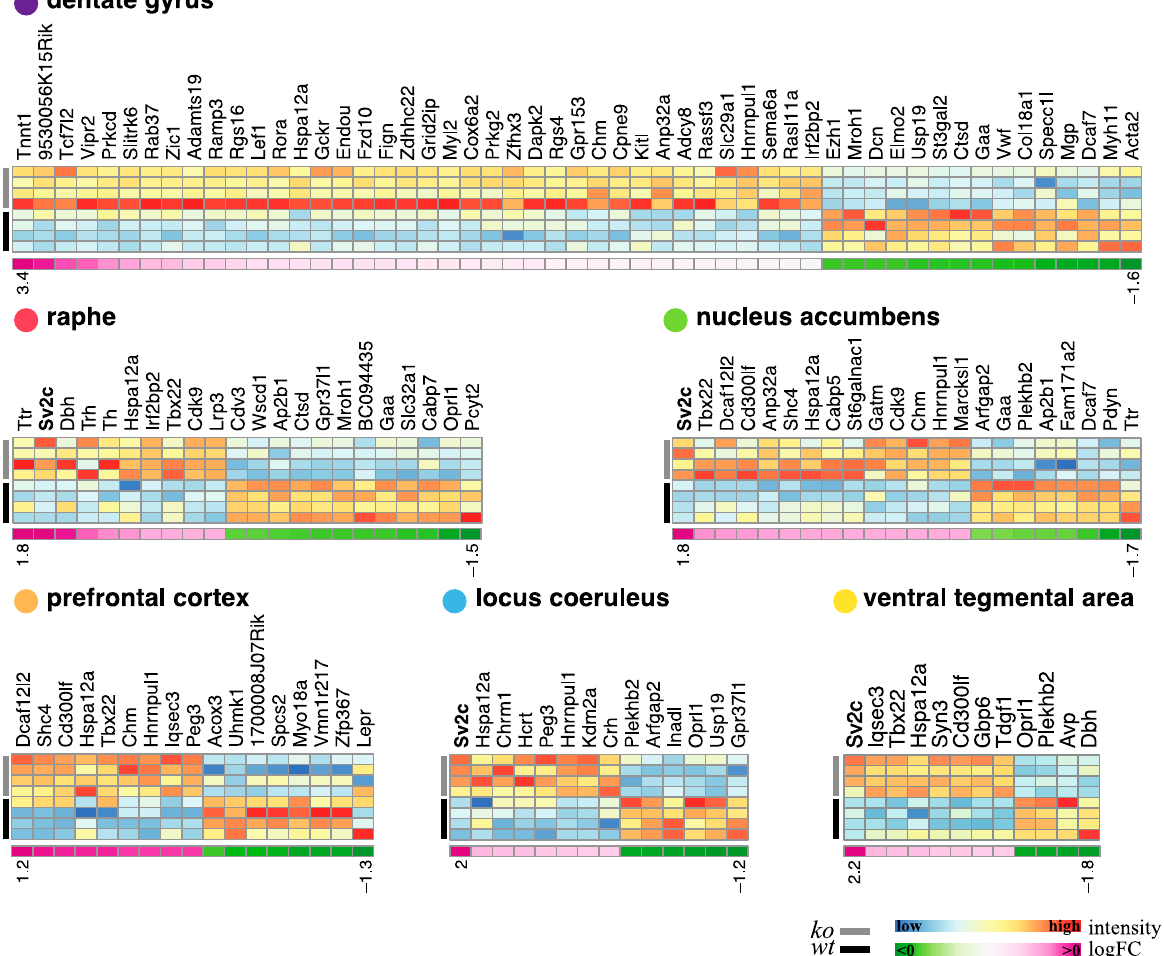
Figure 8. Heatmaps of differentially expressed gene in six brain areas in VMAT2 DBHcre mice. Columns represent the differentially expressed genes (i.e., adjusted p -value ≥ 0.05 and |log fold| ≥ 1), with gene symbol on top, and rows represent the samples with the four rows corresponding to WT samples rows color-coded in black and the four rows corresponding to VMAT2 DBHCre KO in grey. The color temperature varying from blue (low) to red (high) indicates the intensity of expression. As indication, below each heatmap, a single line heatmap displays log fold information with shades of pink for positive values (i.e., genes up-regulated in the KO) and shades of green for negative values (i.e., genes down-regulated in KO). The log fold heat map is not scaled with one another and numbers below each extremity (positive and negative) indicates the range of values for each region.